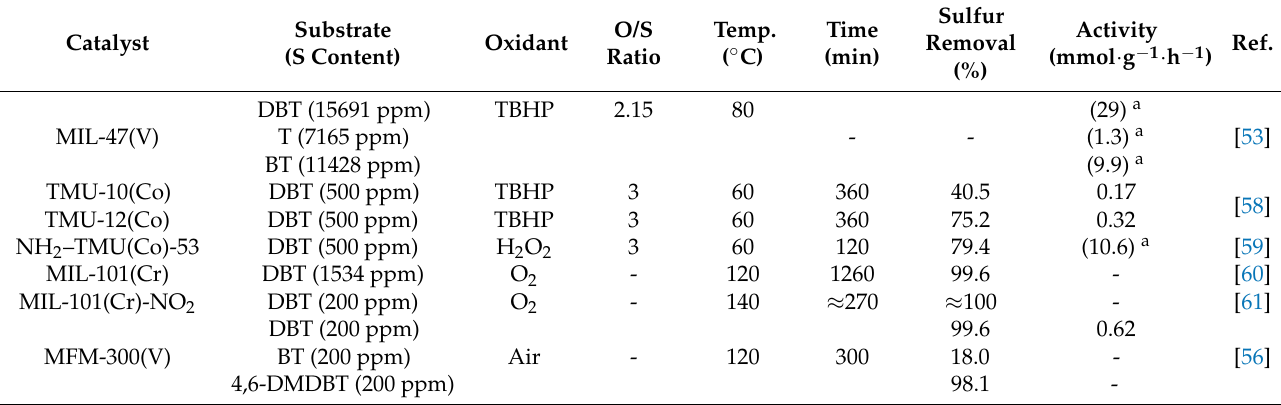
Table 3. Comparison of catalytic performance over other metal-centered MOFs in the ODS reactions of model fuel oil.